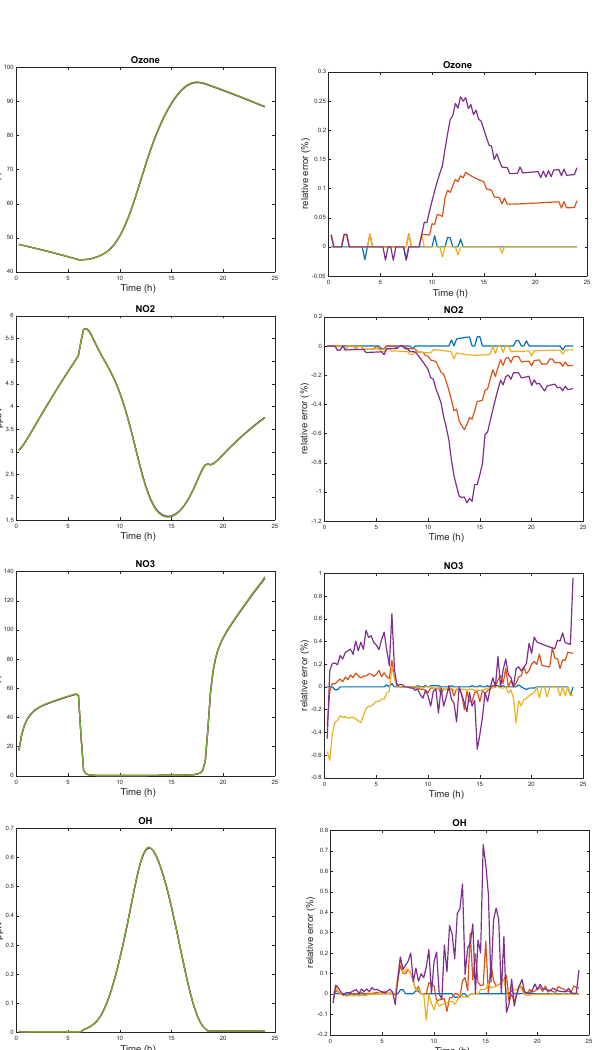
Figure 1. FLUX case. Time evolution of selected species (O 3 , NO 2 , NO 3 , OH) for the R1, G1, A1, A2, and A3 experiments. The left column shows the volume mixing ratios and the right one the differences in percentage (%) relative to the R1 experiment. The color code is the following: blue for G1, orange for A1, red for A2, and purple for A3.